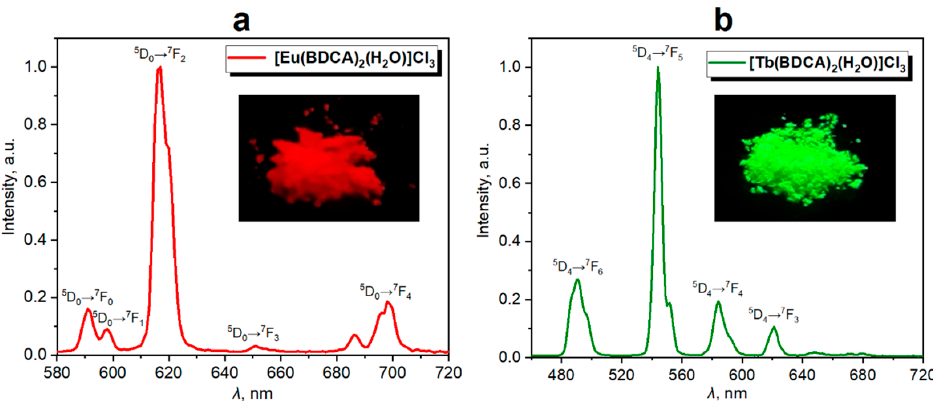
Figure 4. PL emission spectra of [Eu(BDCA) 2 (H 2 O)]Cl 3 ( a ) and [Tb(BDCA) 2 (H 2 O)]Cl 3 ( b ).